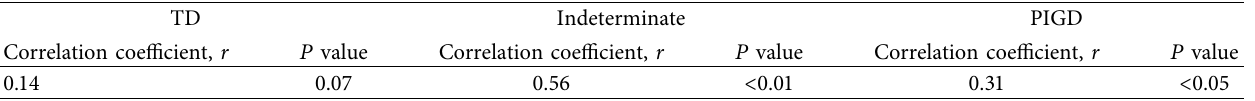
Table 4: Correlation of putaminal %Diff and SCOPA-AUT score aggravation at 48 months of follow-up.